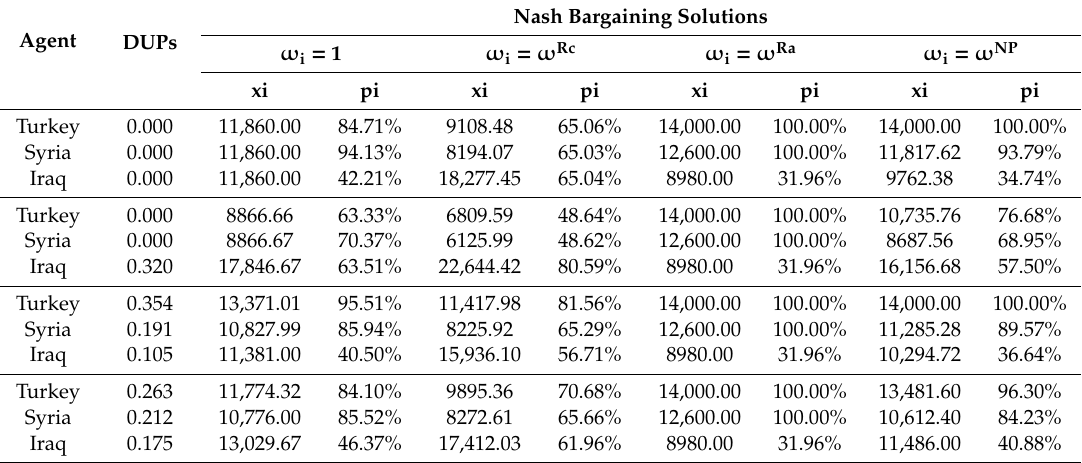
Table 6. Multiple alternative solutions derived from the asymmetric bargaining framework under di ff erent NP and DUP